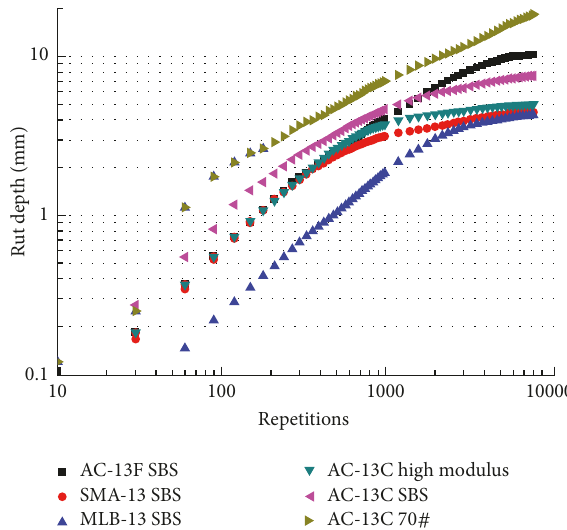
Figure 6: Average cumulative DWPA